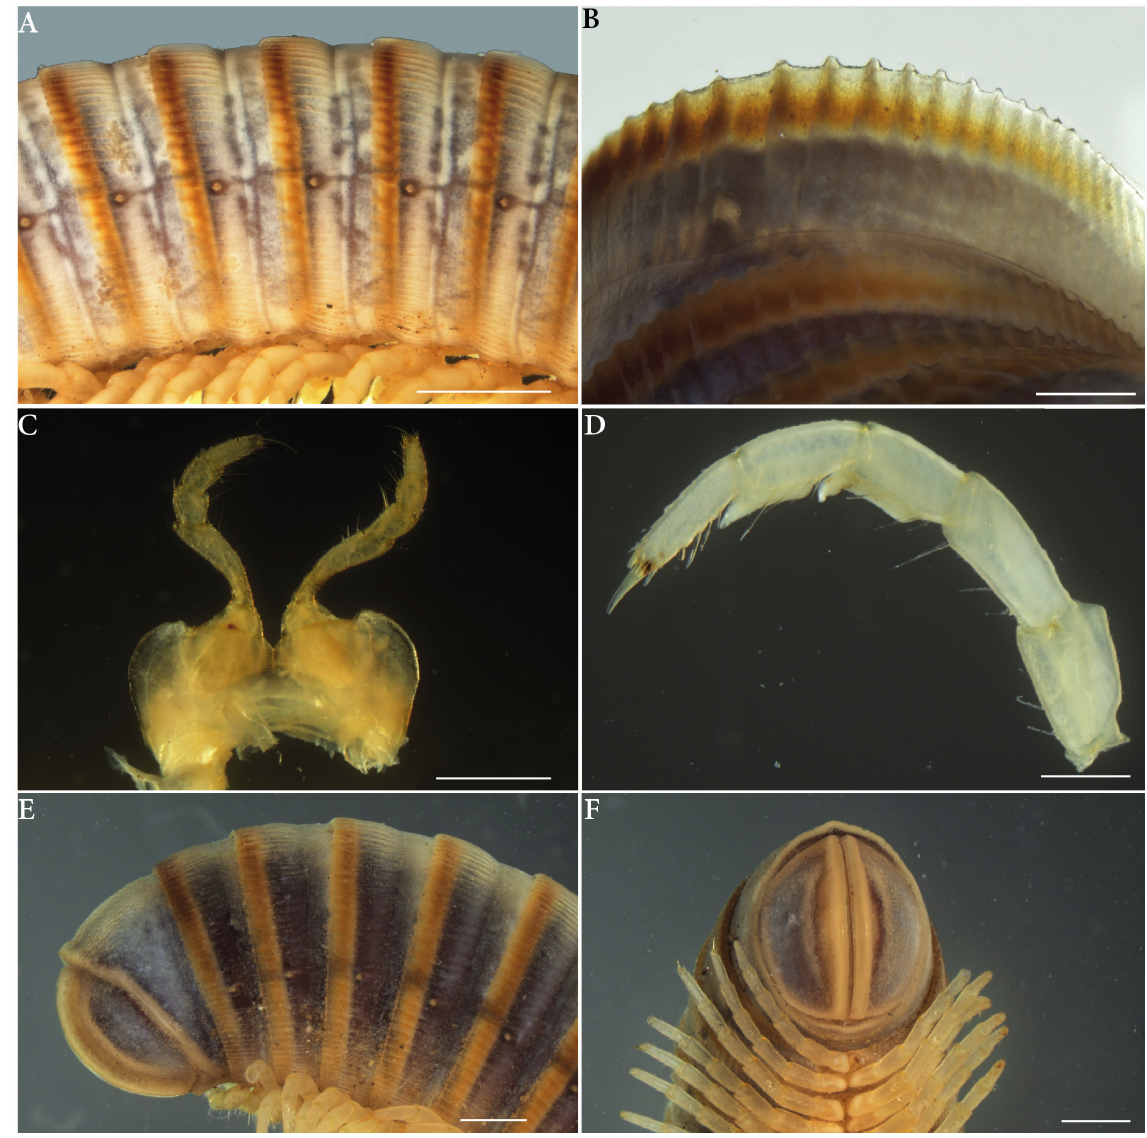
Fig. 3. Attemsostreptus reflexus sp. nov., external structures. A . Midbody rings in lateral view, telson towards the left, female paratype. B . Limbus, male holotype (NHMD607065). C . First pair of legs, male holotype (NHMD607065). D . Midbody leg with soft pads, male holotype (NHMD607065). E. Posteriormost body rings and telson in lateral view, female paratype. F . Posteriormost body rings and telson in ventral view, female paratype. Scale bar: 1